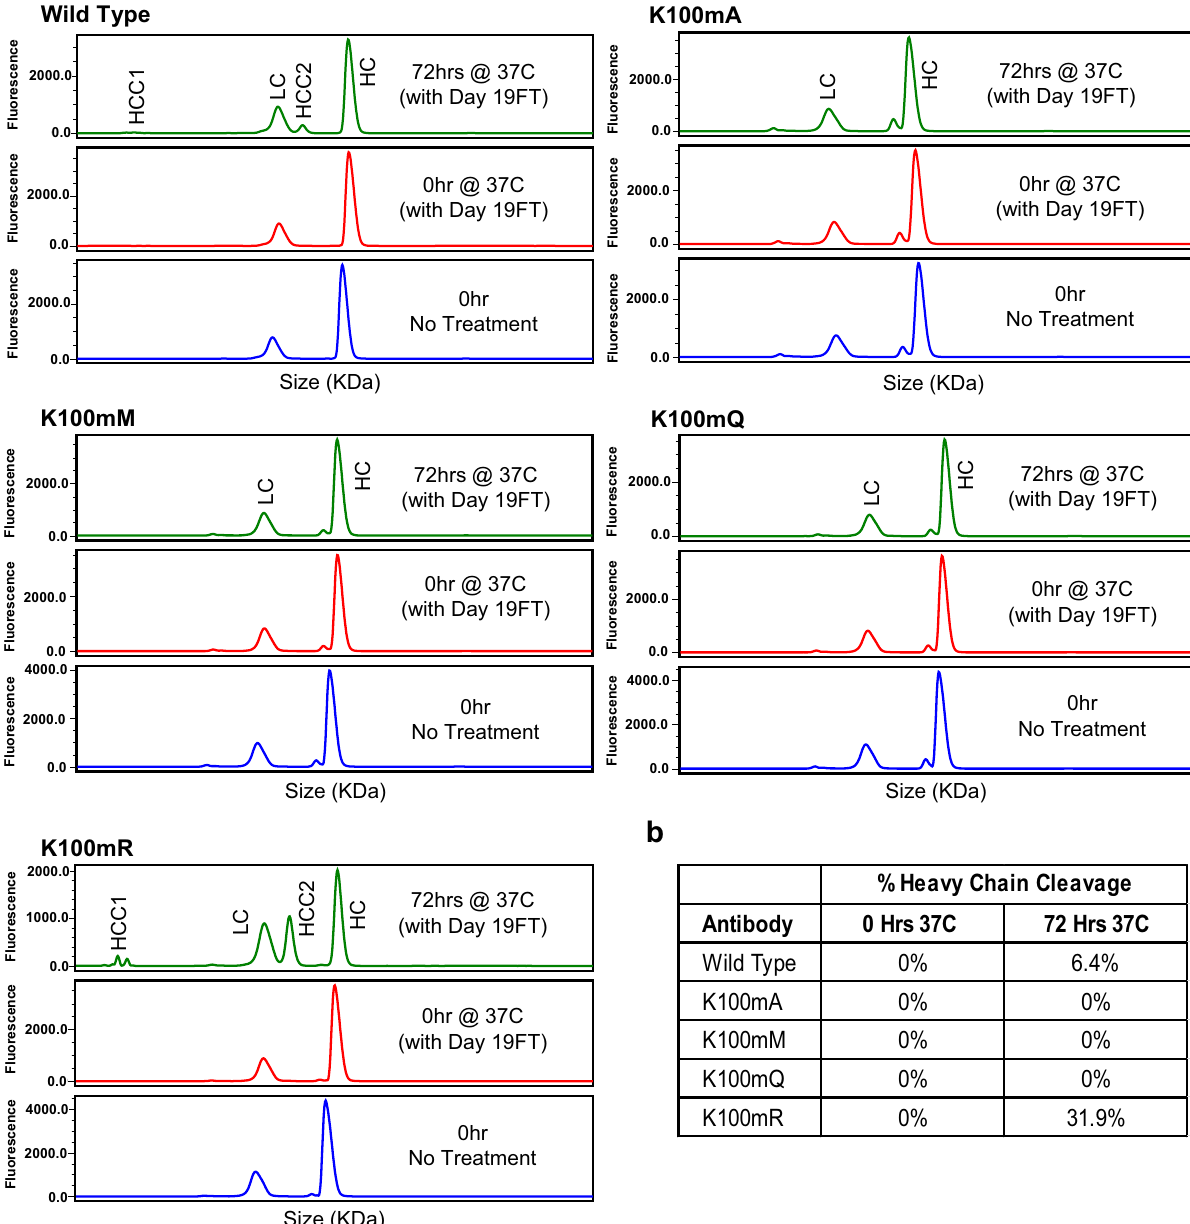
Figure 2. CAP256-VRC26.25 variants resist cleavage. ( a ) Samples were treated with day 19 CHO supernatant flow-through containing protease (Day 19FT) for 0 or 72 h. Treated and untreated samples were separated by size using reducing capillary gel electrophoresis. Peaks labelled HCC1, HCC2 contain clipped product; HC contains unclipped heavy chain, LC contains light chain. ( b ) % Cleaved heavy chain showing 0 and 72 h treatments. % HCC was calculated as area of each peak divided by total area of all